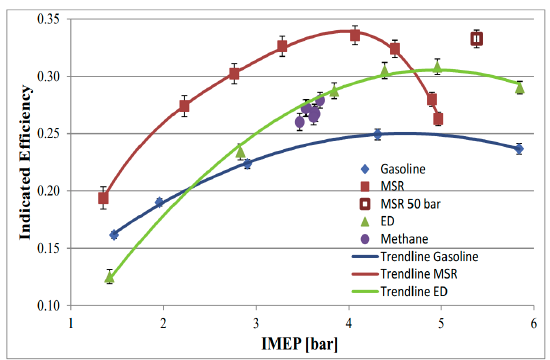
Figure 17. ITE at various load engines at 2800 rpm [288].